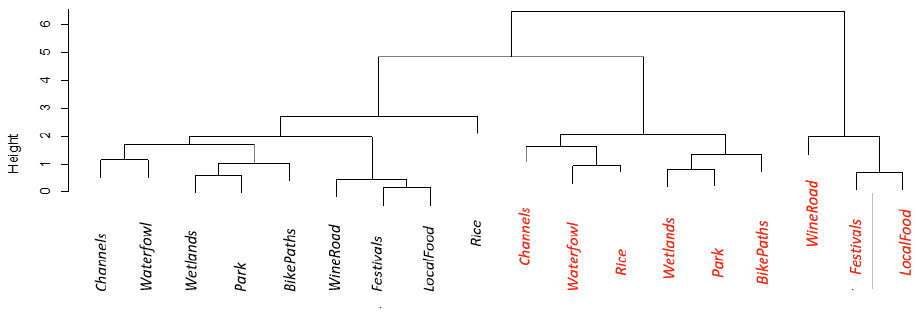
Figure 3. Hierarchical cluster analysis performed on the first 5 axes of the multiple correspondence analysis (overall 54% of variance explained). The dendrogram shows the similarity between the vari- able categories (acronyms are presented in figure 2). Labels identifying a heterogeneous perception of benefits between agricultural and tourism sectors, and residents are reported in red; categories linked to a homogenous perception are reported in black.